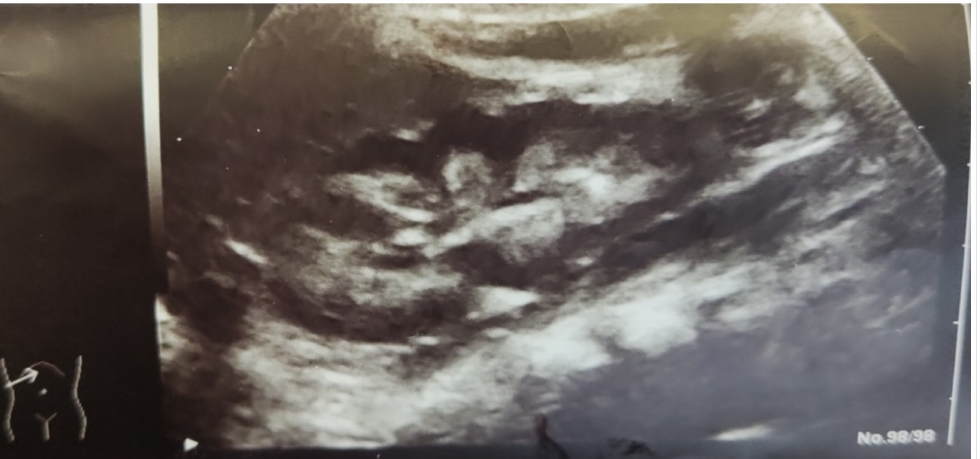
Figure 3. Ultrasonography of the kidney showing increased echogenicity of the medullary pyramids